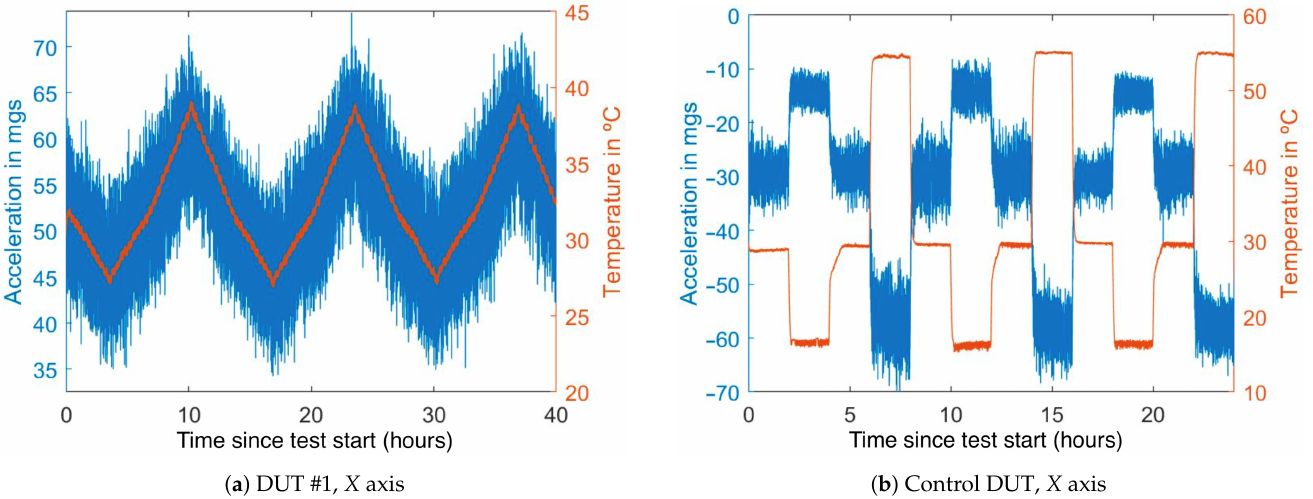
Figure 7. Simultaneous temperature (in red) and acceleration (in blue) variations during the